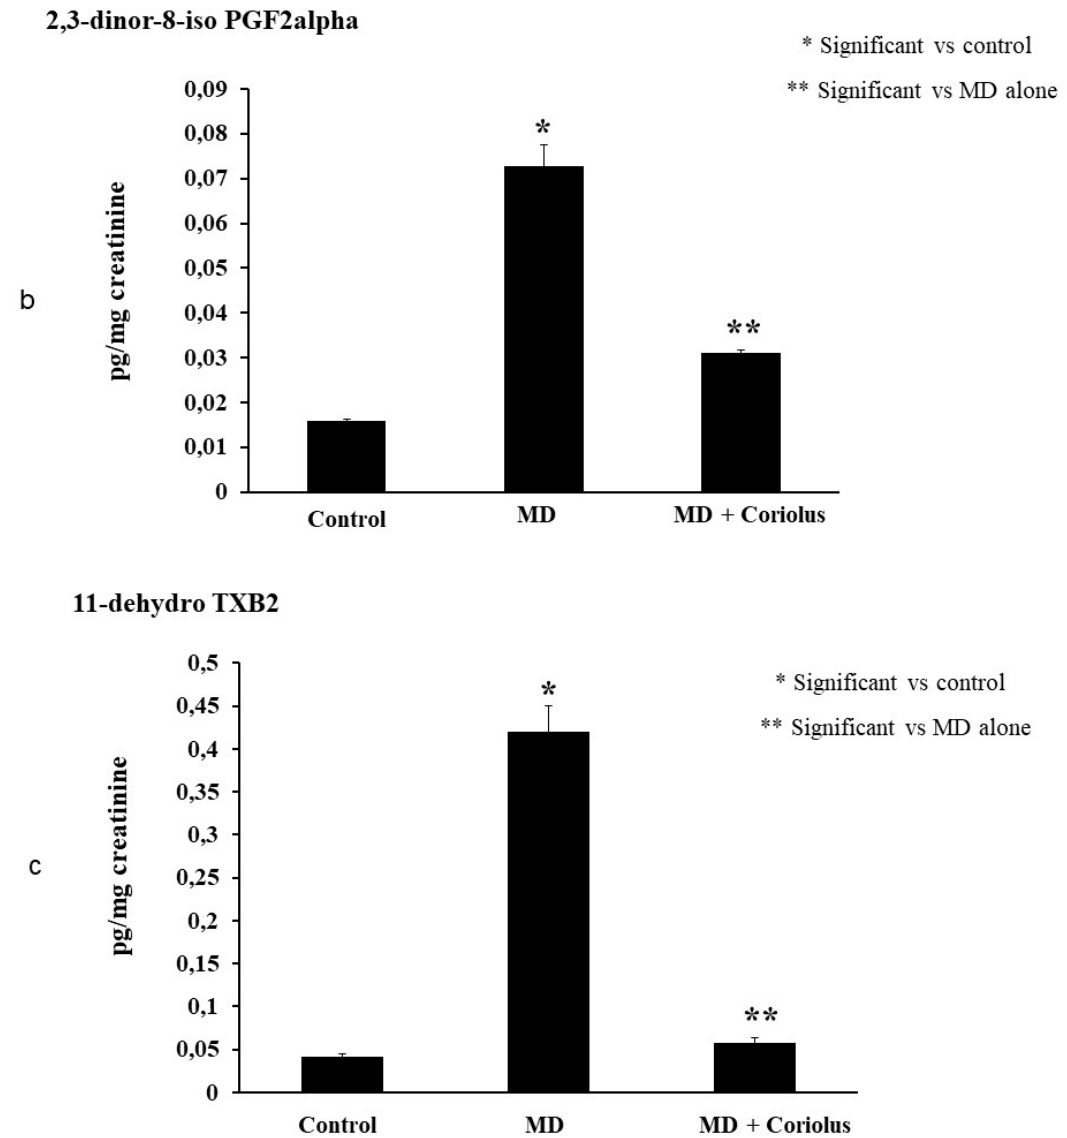
Figure 9. Lipidomic analysis of bioactive lipids. Analysis of urinay pro-inflammatory eicosanoids, 11-dehydro TXB2, isoprostane PGF2 α , isoprostane iPF2 α -VI, showing opposite results with significant higher levels of these bioactive lipids in MD subjects than the levels found in Coriolus administered